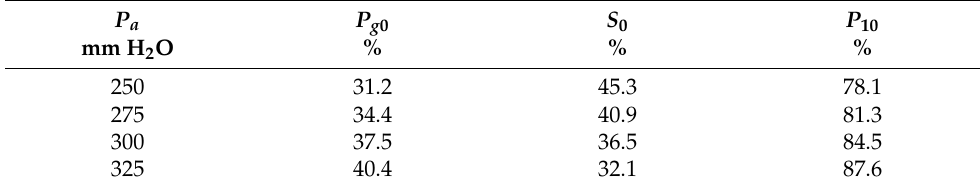
Table 8. Values of steady-state